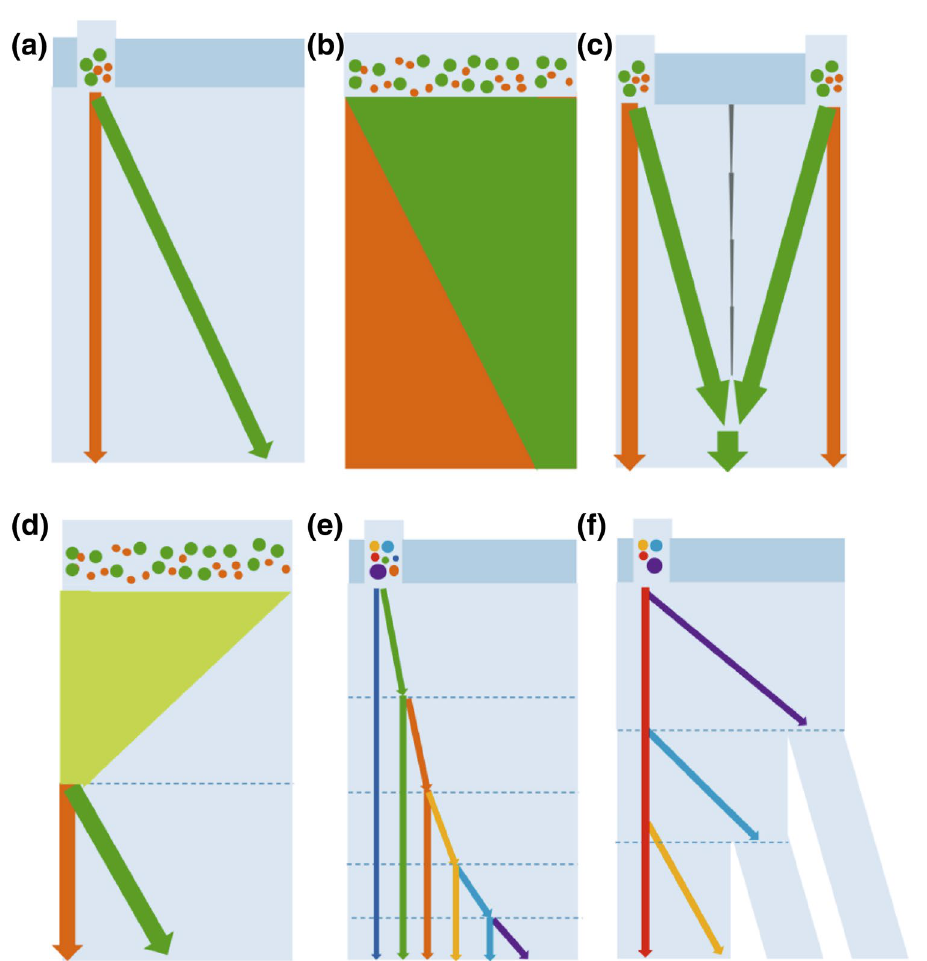
Fig. 4 DLD device layout designs for binary and multiple separations. a Simple single array design, b condenser array design, c mirrored array design, d condenser and sorter array design, e chirped array design, and f cascade array